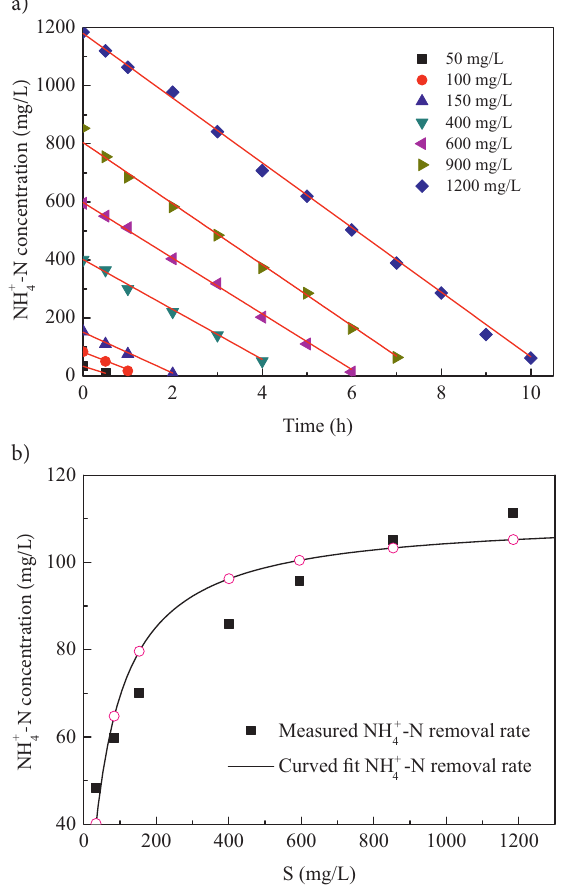
Figure 1. NH 4+ -N concentrations every hour (a) and basic Monod model for NH 4+ -N removal rate